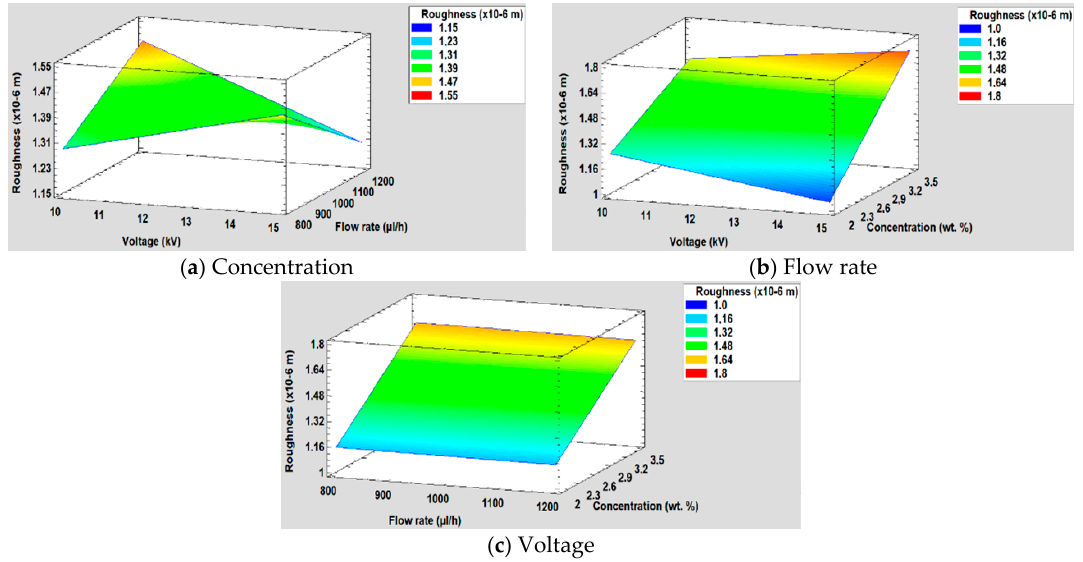
Figure 12. ( a ) Concentration, ( b ) Flow rate and ( c ) Voltage surface response in the surface roughness.